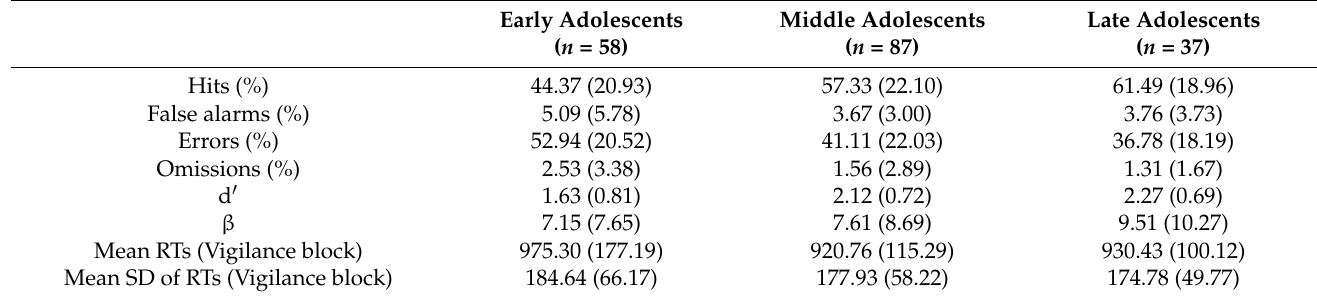
Table 2. Mean reaction times (in milliseconds) and percentage of accuracy for each age group.